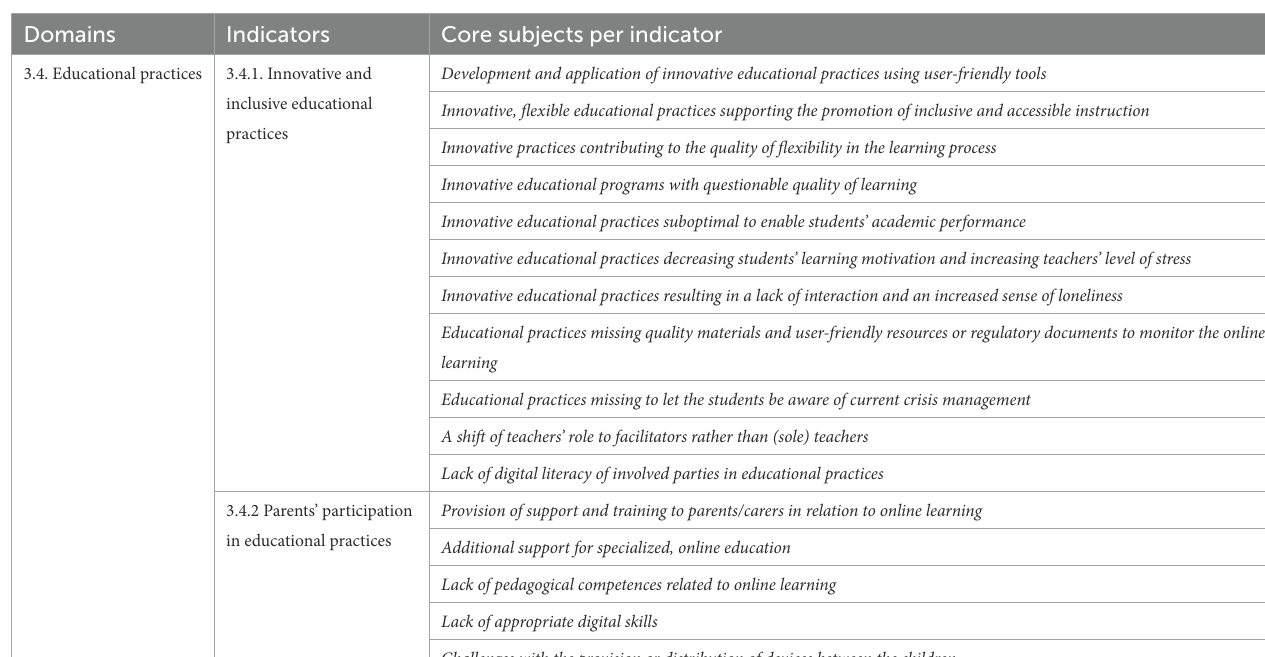
TABLE 5 Domain of educational